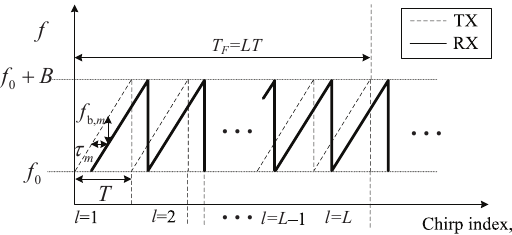
Figure 2. Transmit and receive signals of frequency-modulated continuous-wave (FMCW)